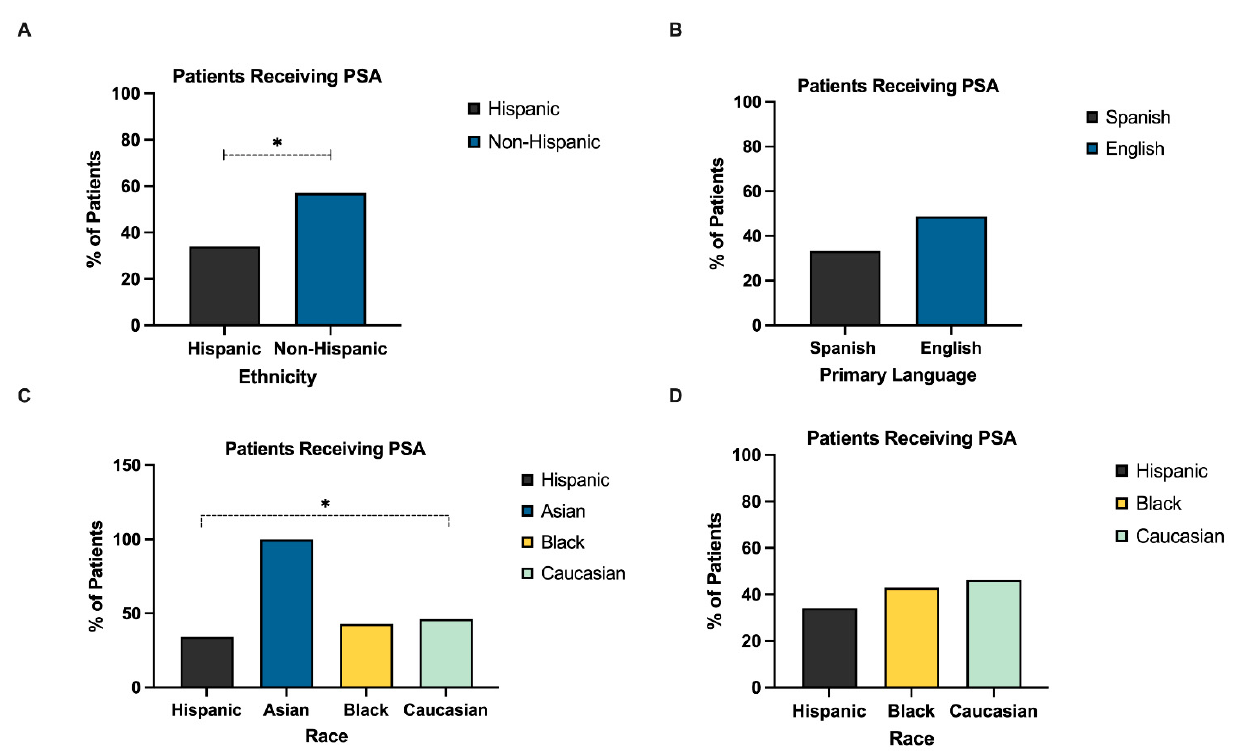
Figure 2. Factors affecting use of procedural sedation and/or anxiolysis. ( A ) Significantly more non-Hispanic patients received PSA compared to Hispanic patients. ( B ) There was no statistically significant difference in PSA between Spanish and English speakers. ( C ) There was a statistically significant difference in PSA based on race, with 46.2% of Caucasian patients, 42.9% of Black patients and 100% of Asian patients receiving PSA, compared to 34.1% of Hispanic patients. ( D ) Comparison of PSA based on race, excluding Asian patients, demonstrates no significant difference in PSA based on race. PSA, procedural sedation and/or anxiolysis. (* = p < 0.05).